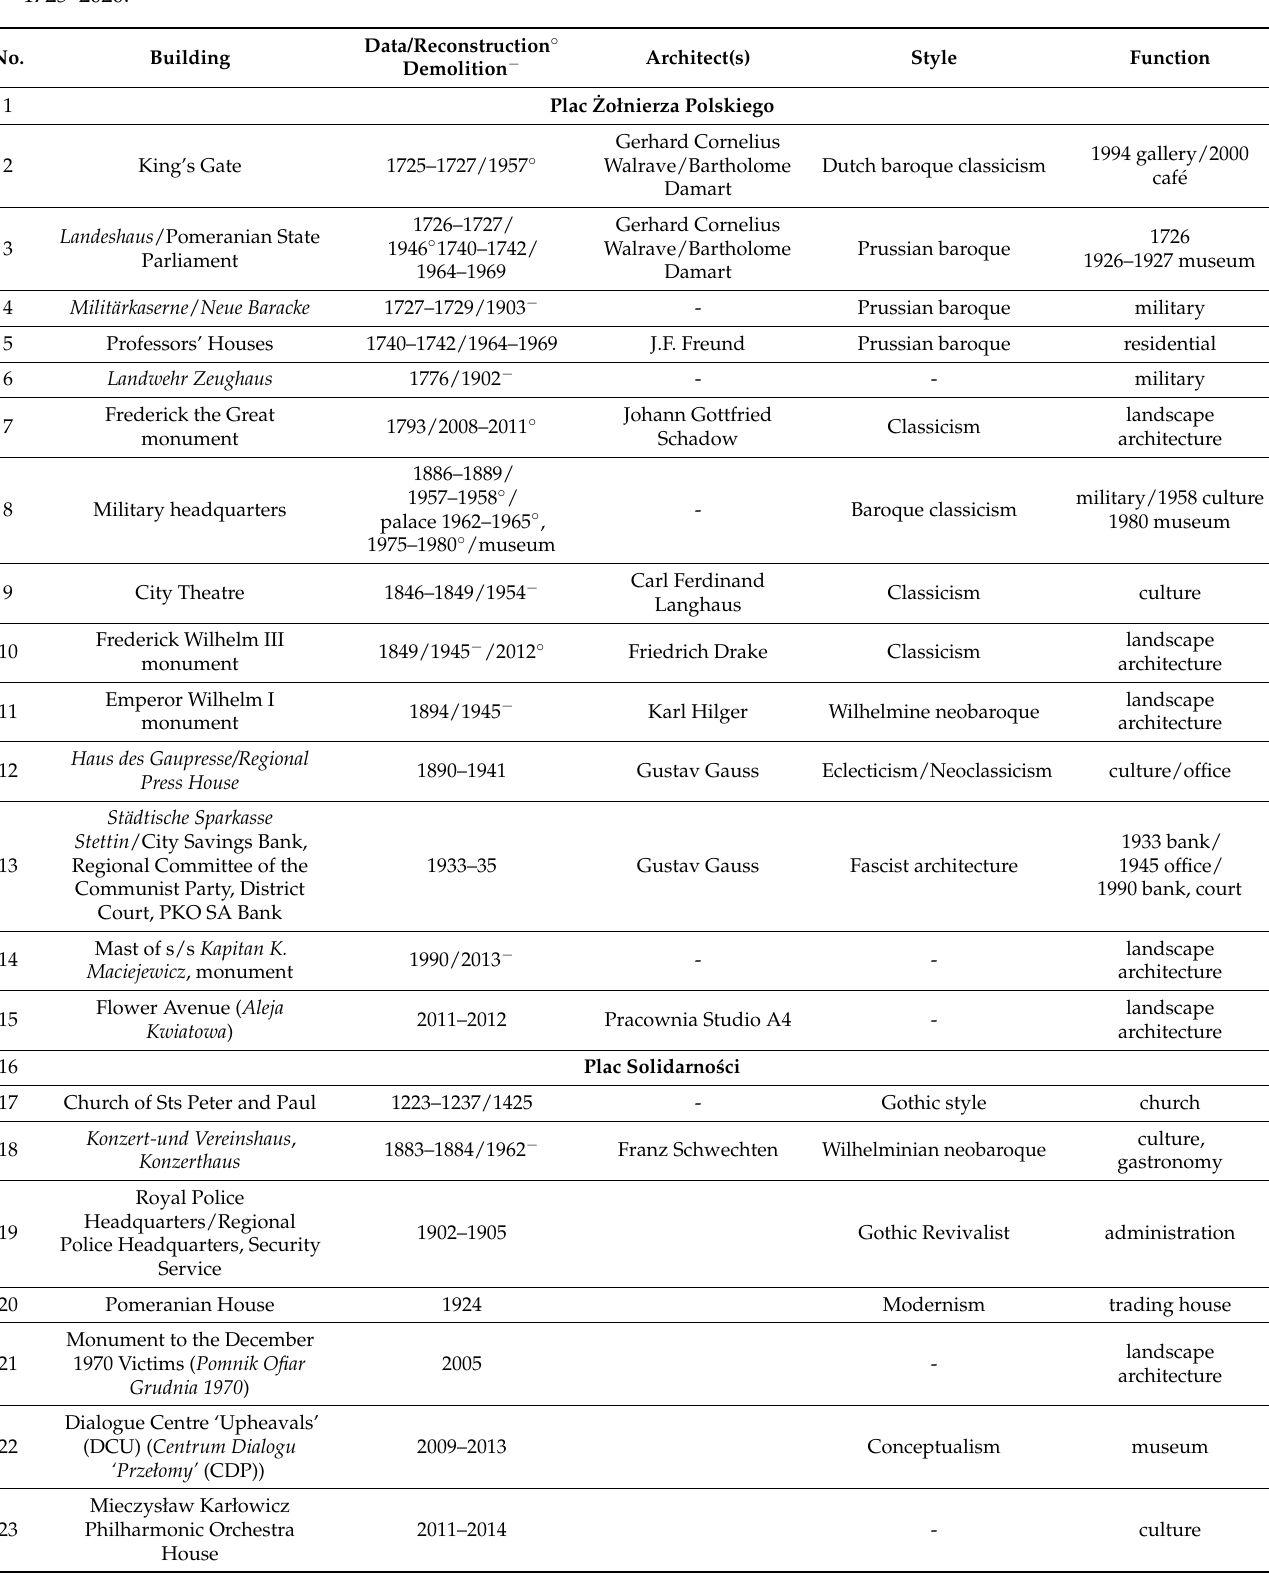
Table 1. The complex of architectural structures located on plac ˙Zołnierza Polskiego and plac Solidarno´sci in Szczecin,